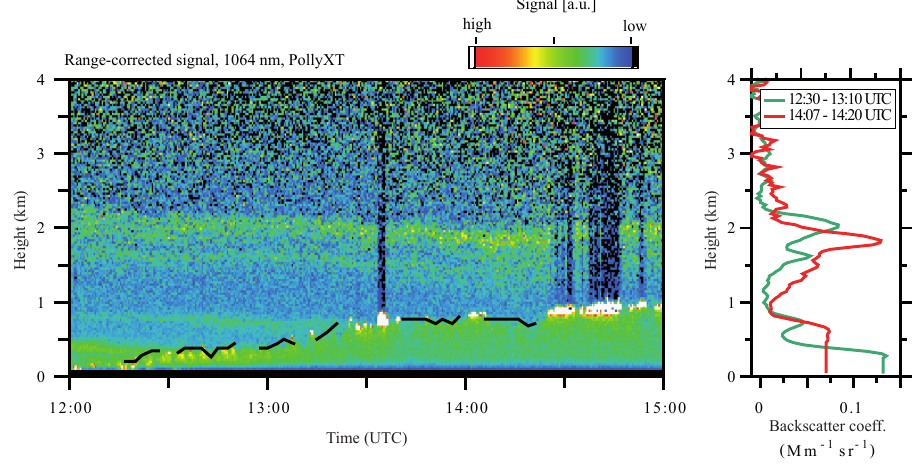
Fig. 11. Vertical profile measured by the PollyXT LIDAR at the Silvicultura site on 13 March 2008. (Left) False-color representation of the time series of the range-corrected signal at 1064nm. Blue and black represent low backscattering that is characteristic of gases. Green and yellow indicate high backscattering that is characteristic of particles. White shows very high backscattering, which is often caused by clouds. The broken black line represents the top of the planetary boundary layer. (Right) Height-resolved backscatter coefficients averaged across two different time periods.